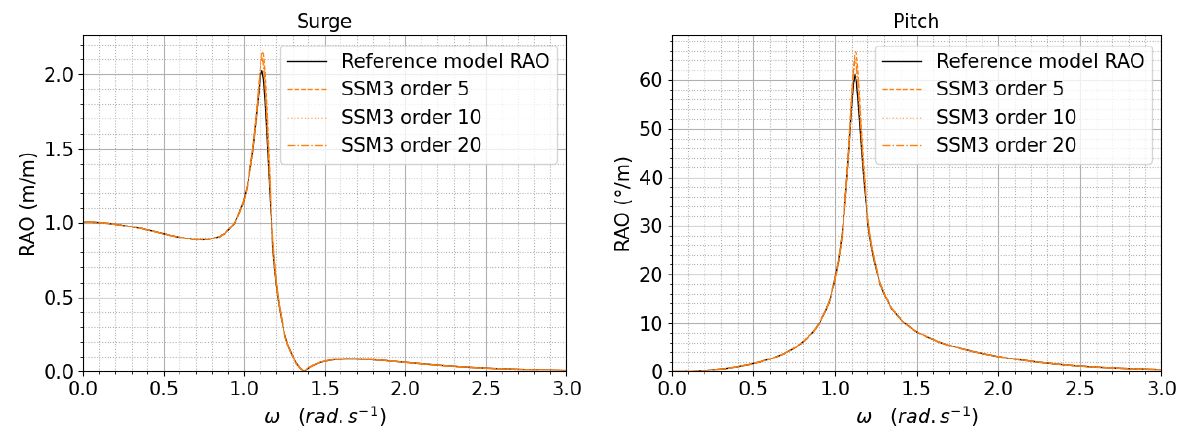
Figure 7. Comparison between SSM3 and the reference RAO for surge and pitch motions.